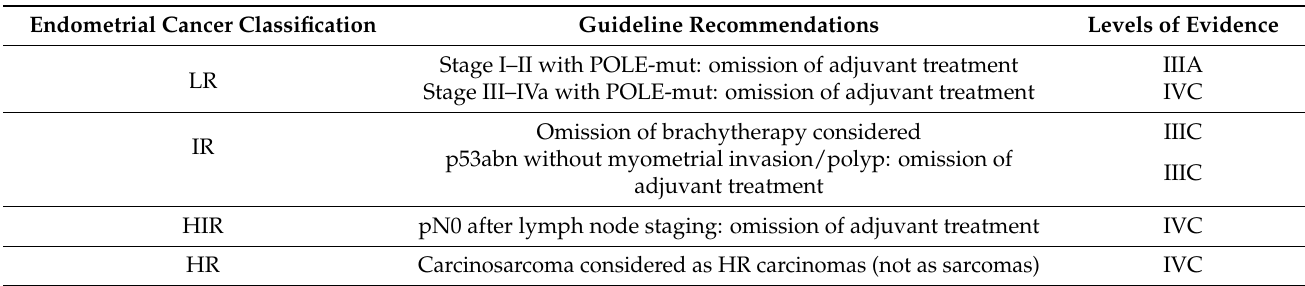
Table 3. Lack of evidence in endometrial cancer